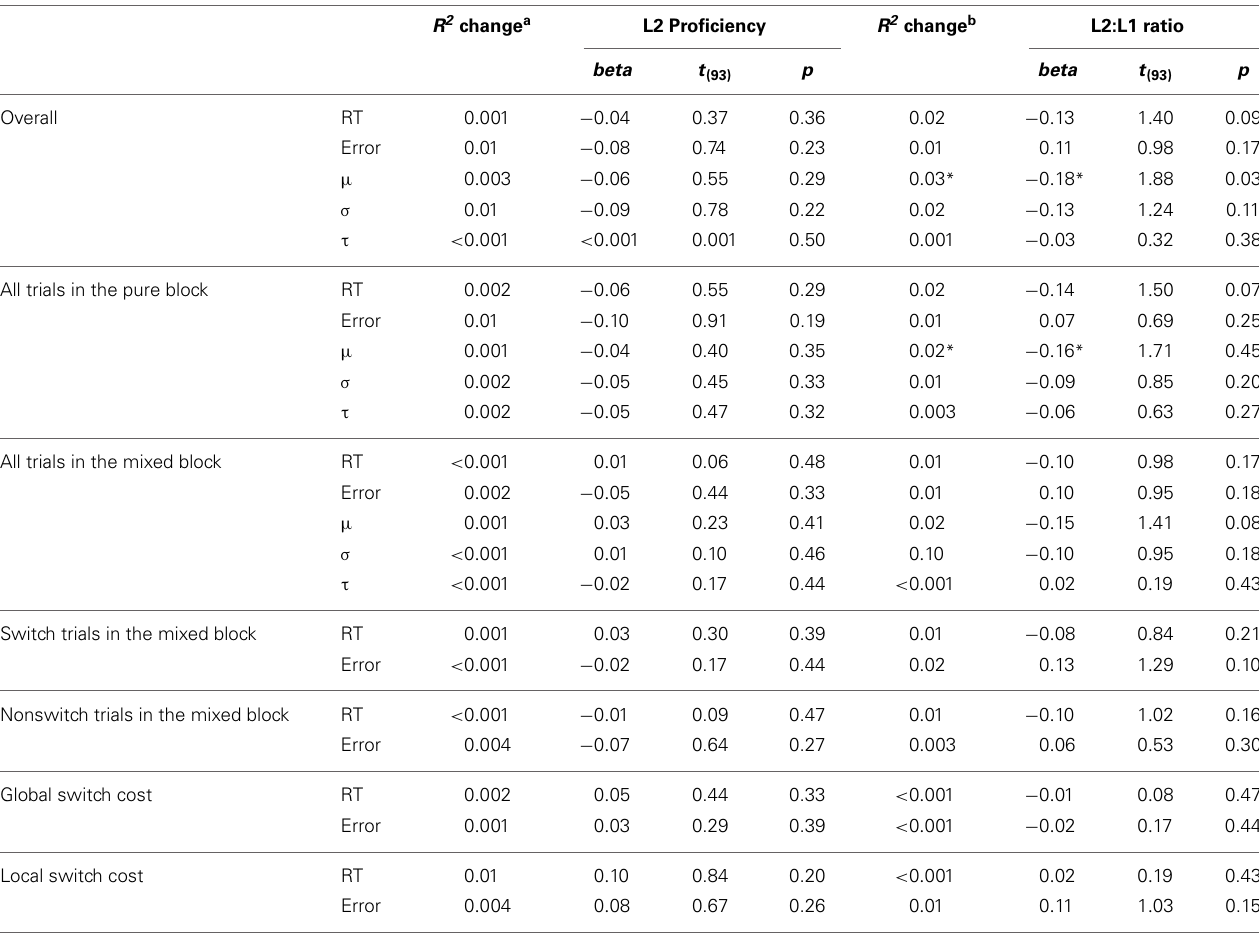
Table 5 | Mean statistics and findings of regression analyses for participants’ performance in the Simon switching task after partialling out the participants’ age (i.e., cognitive